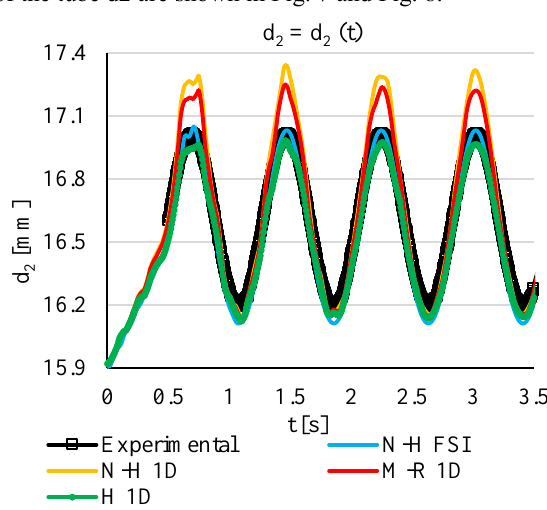
Fig. 7. Outer diameters d 2 of the thick-walled tube.